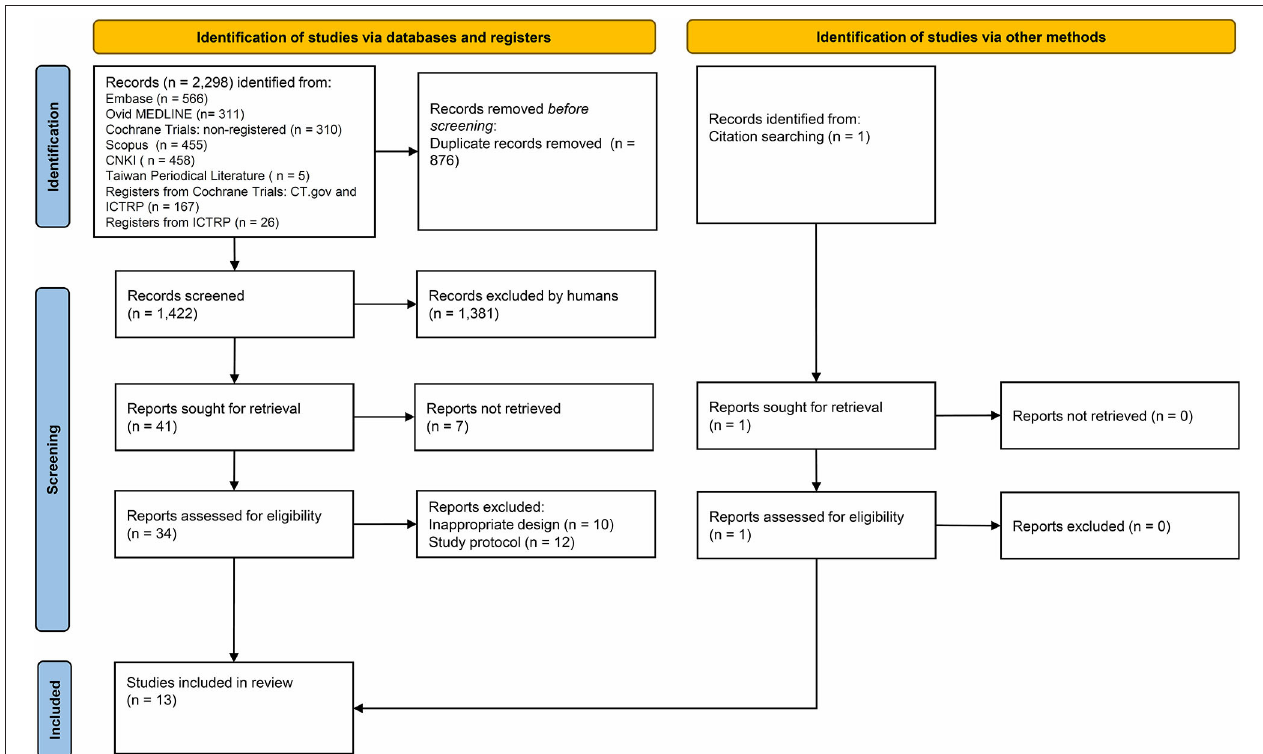
FIGURE 1 | A PRISMA 2020 flow chart of the study selection